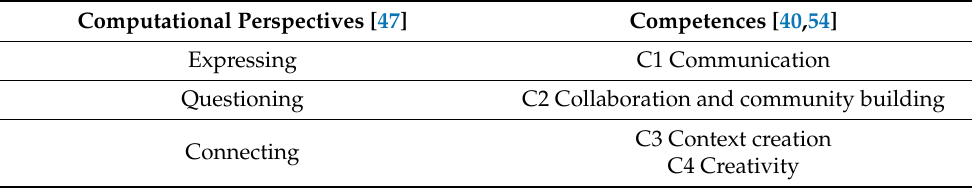
Table 3. Relationships between CT perspectives and